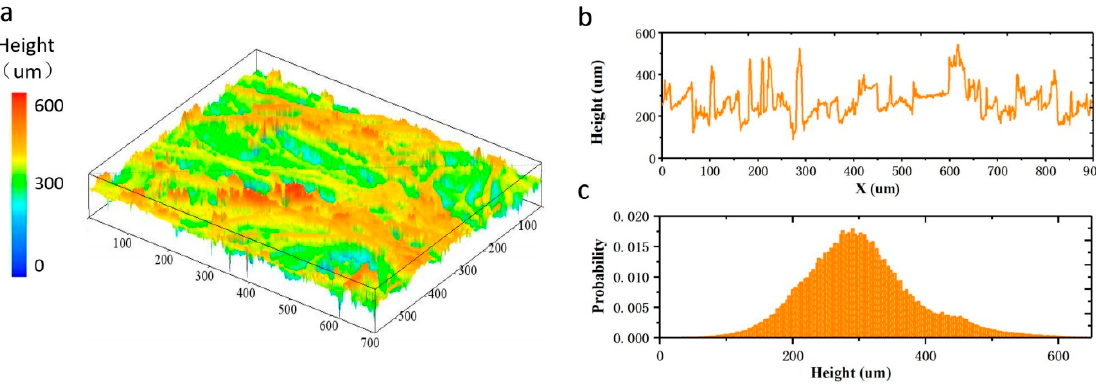
Figure 2. Characterization of the prepared Gaussian random distribution samples. ( a ) Three-dimensional (3D) morphology of the PANI coated fabric; ( b ) Height profile corresponding to the marked cross profile on the diagonal; ( c ) Probability distribution of the surface height.